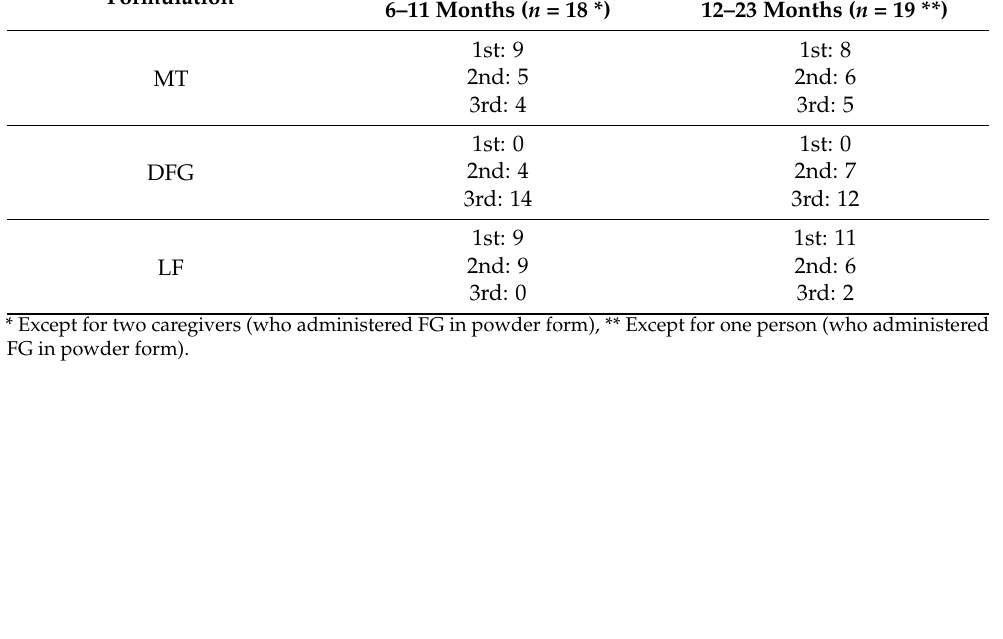
Table 3. Ranking of the formulations based on the ease of use by the caregivers.